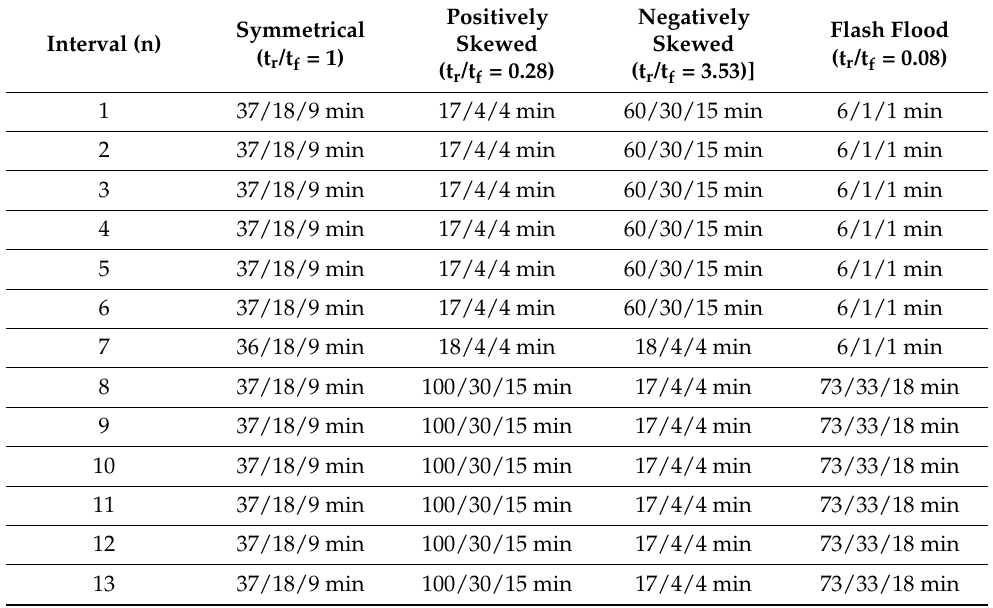
Table A1. Duration of discharge intervals in experimental hydrographs in Series